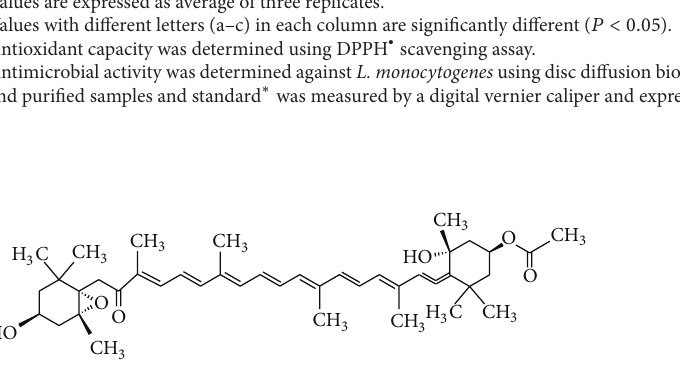
Figure 2: Chemical structure of fucoxanthin (molecular formula: C 42 H 58 O 6 ).